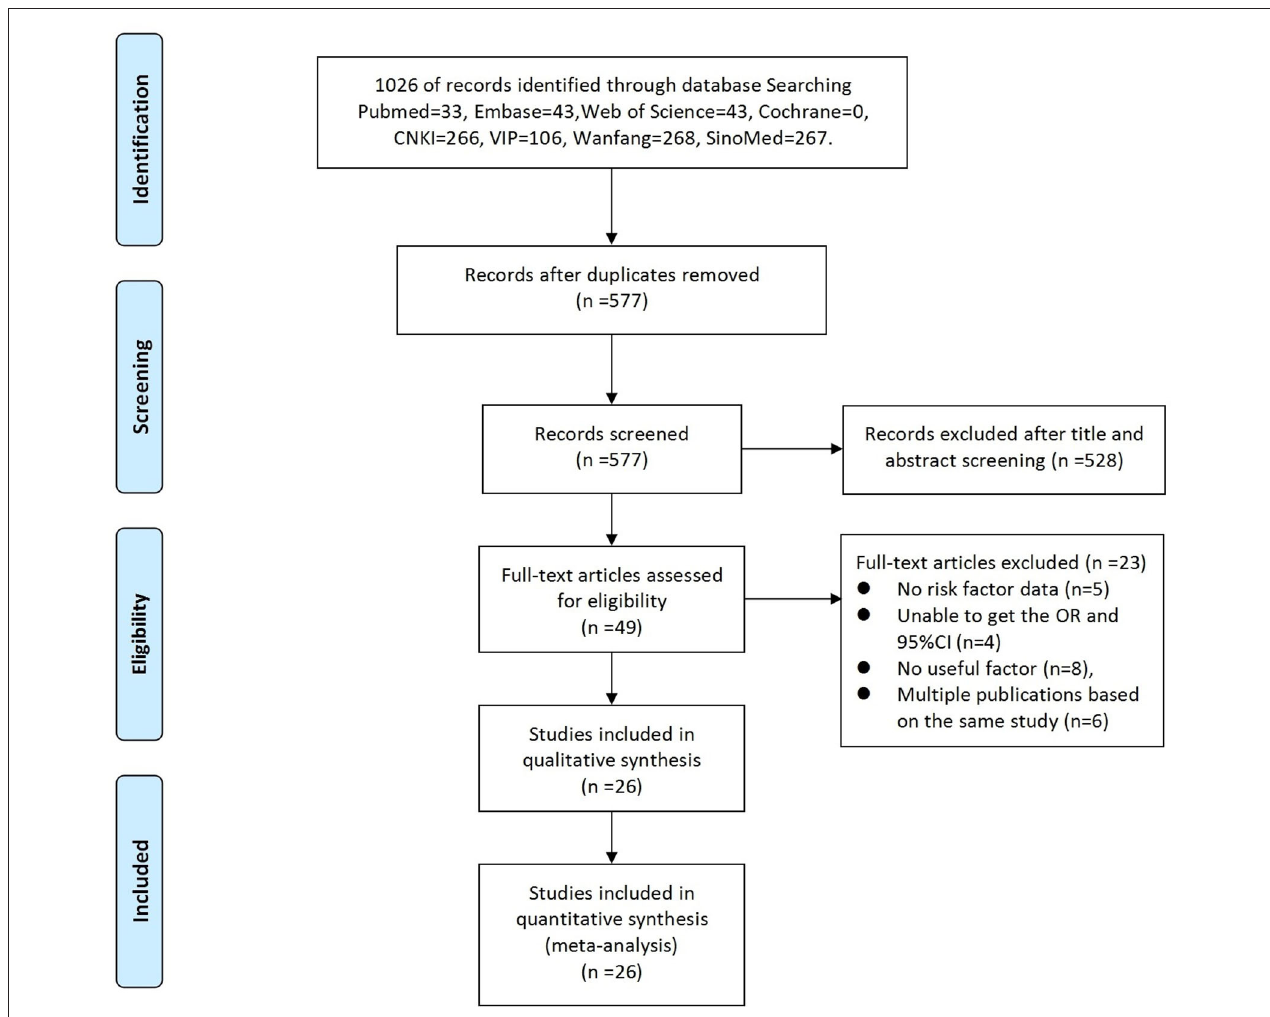
FIGURE 1 | Summary of the literature search and study